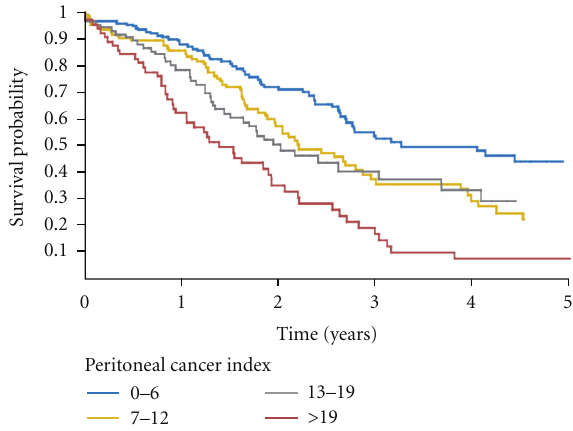
Figure 2: Prognostic impact of the extent of carcinomatosis (i.e., peritoneal cancer index; P < 0 . 001) on overall survival